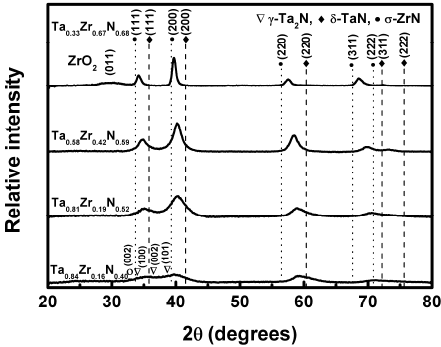
Figure 5. XRD patterns of the Ta–Zr–N thin films after annealing at 600°C in 15 ppm O 2 ‐ N 2 for 8 h.